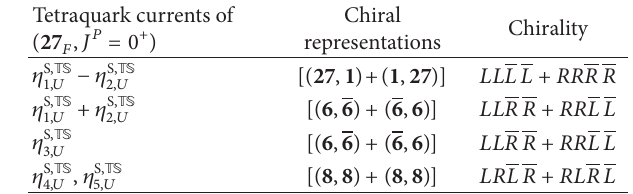
Table 5: Flavor octet tetraquark currents of 𝐽 𝑃 = 0 − classified in